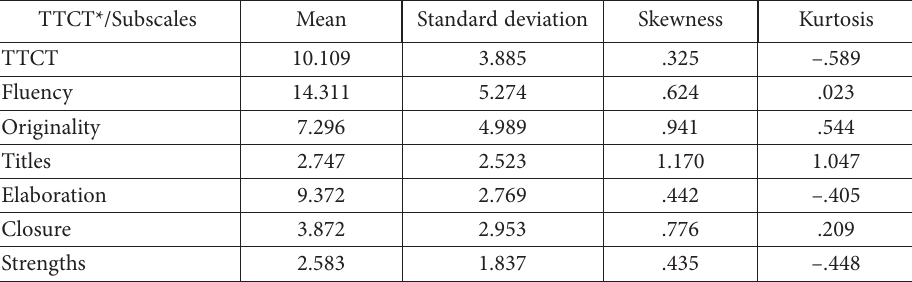
Table 1. Descriptive statistics: the originality, fluency, (abstractness of) titles, elaboration, (resistance to premature) closure, and creative strengths (source: created by author)